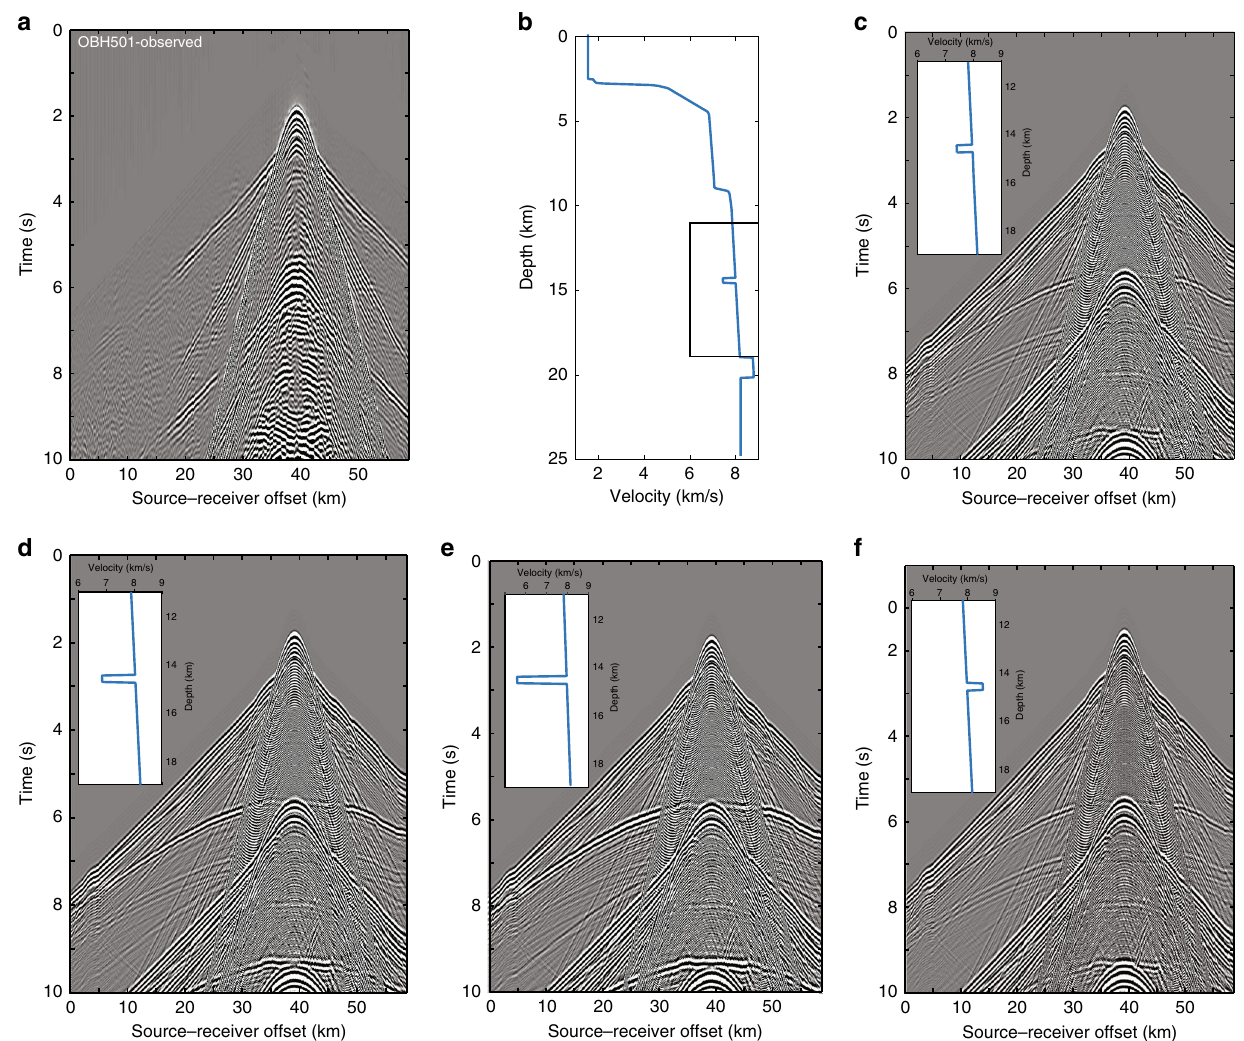
Fig. 4 Synthetic seismograms. a The observed data recorded by the instrument OBH 501, b a template for 1D velocity model where the upper mantle layer is 300-m thick with a velocity decrease of − 7% and a 1200-m-thick lower layer with an increase in velocity of + 7%. The black rectangle indicates the blow of the velocities shown in subsequent panels. c Synthetic seismograms for the velocity model shown in ( b ). d Synthetic seismogram for velocity in the upper layer of − 15%, e − 30% and f + 7%.